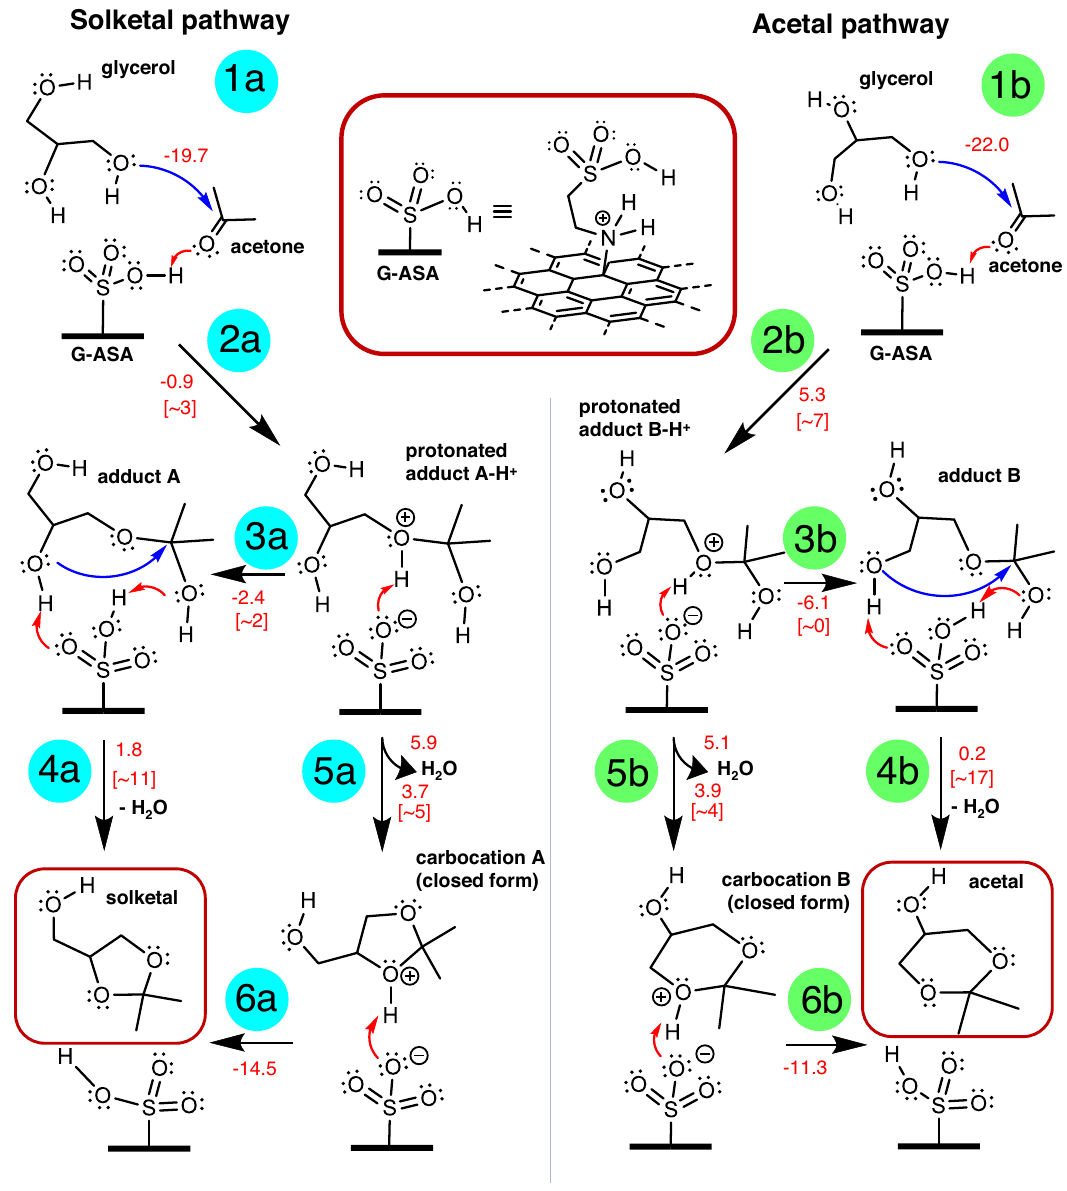
Fig. 4 | Mechanism of the catalytic reaction. Plausible mechanistic solketal (left) and acetal (right) pathways of the acetalization of glycerol with acetone on the G-ASAcatalyst.Electronicreactionenergiesandactivationbarriers(inparentheses)